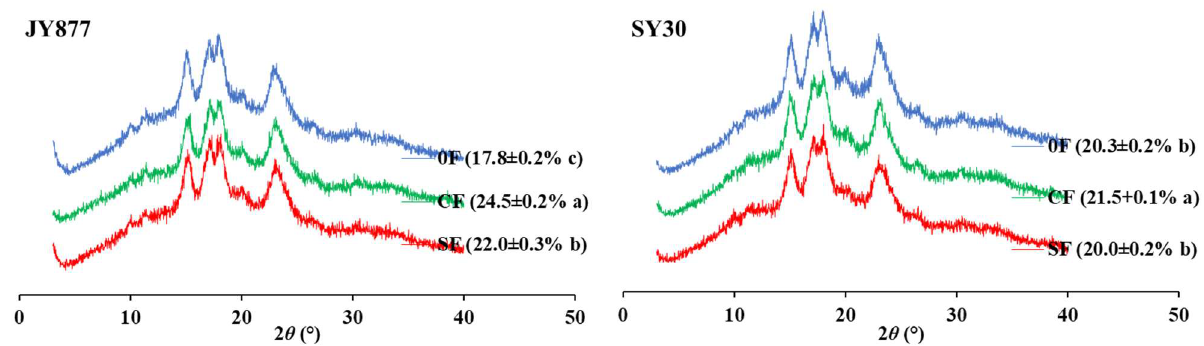
Figure 4. Effects of the fertilization mode on starch X-ray diffraction pattern of normal maize. The Data in brackets are the relative crystallinity. Mean values within the same hybrid followed by different letters are significantly different at p < 0.05. JY877, Jiangyu877; SY30, Suyu30; 0F, zero fertilization; CF, common fertilization; SF, slow-release fertilization.